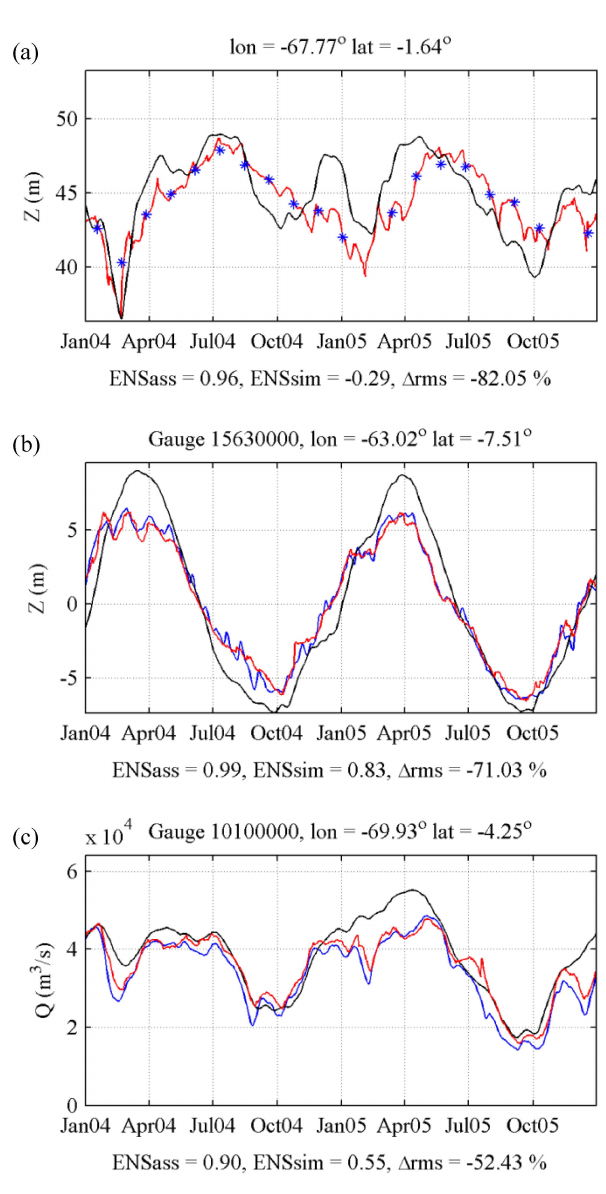
Fig. 5. Observation (blue line), open-loop simulation (black line) and EnKF simulation (red line) at (a) Japur´a River altimetry site, (b) Madeira River in situ stage site (c) Solim˜oes River in situ discharge site. Sites are indicated in Fig. 4.